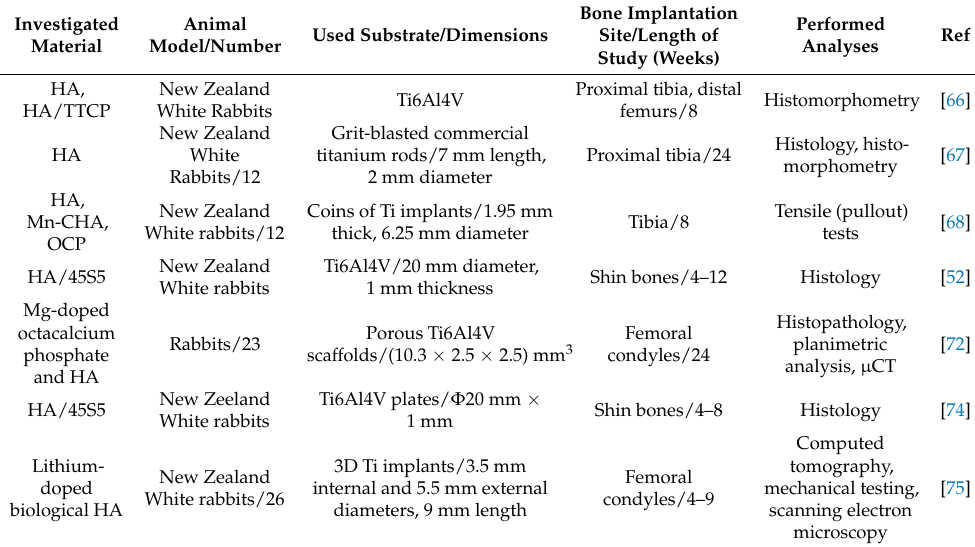
Table 4. Information related to the investigated coating materials, according to the applied small animal models (i.e.,